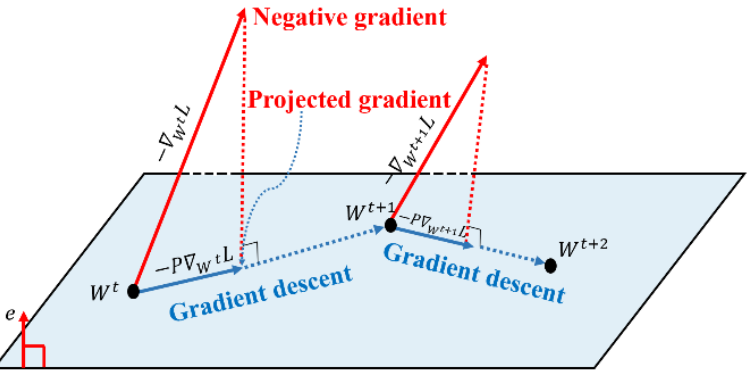
Figure 5. The geometrical interpretation of GC.